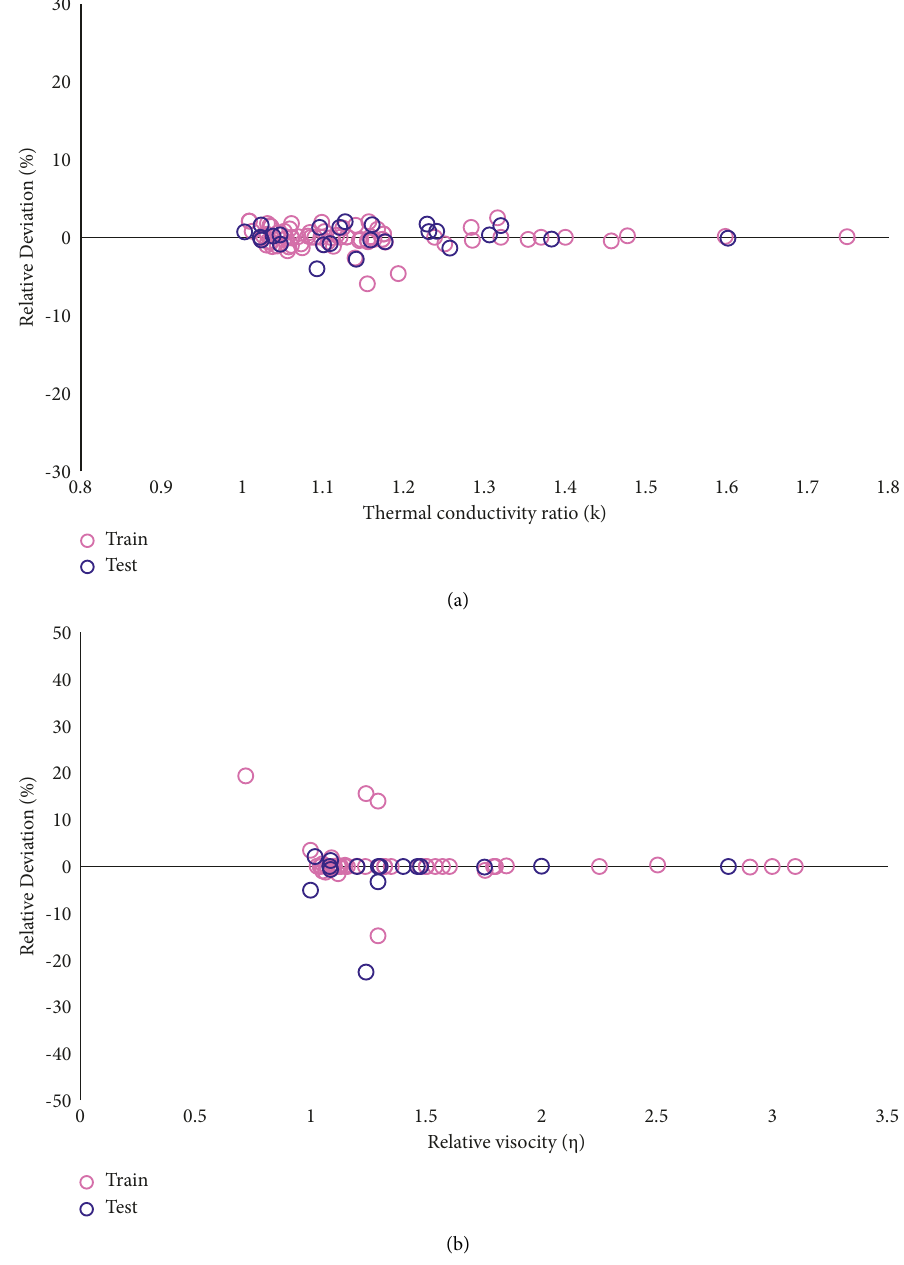
Figure 4: Relative deviation analysis of the (a) TC ratio and (b) relative viscosity of NFs. Furthermore, the validity of the proposed model is measured by statistical factors. To predict errors, R 2 , RMSE, MSE, STD, and MRE are used in Table 1 [55–59]. Table 1: Statistical parameters obtained to estimate the accuracy of the PSO-ANFIS